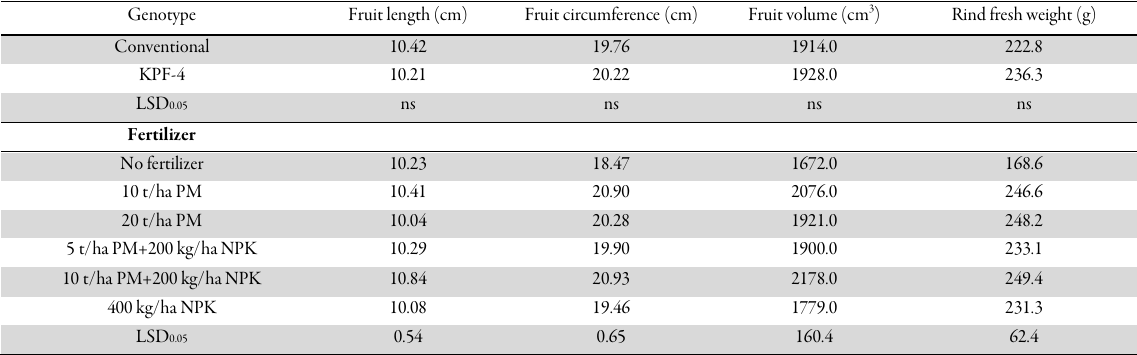
Table 3. Main effects of genotype and fertilizer on fruit metric traits of two yellow passion fruit genotypes grown in the field in 2017